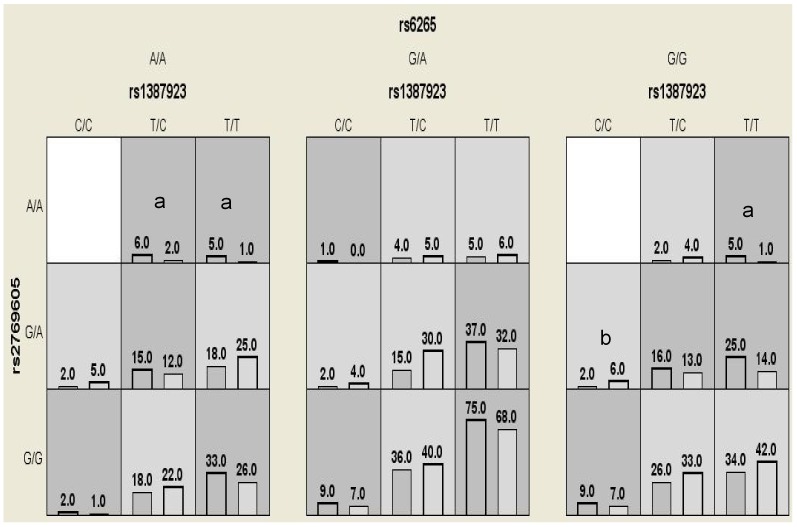
Distribution of high-risk and low-risk genotypes in the best three-locus model.Dark gray and light gray boxes presented the high- and low-risk factor combinations, respectively. Left bars within each box represented case while the right bars represented control. The heights of the bars are proportional to the sum of samples in each group. Note that the patterns of high-risk and low-risk cells differ across each of the different multilocus dimensions. This is evidence of epistasis, or gene-gene interaction. “a” and “b” represented high-risk and low-risk genotype combinations respectively which were also validated by traditional statistical analysis.